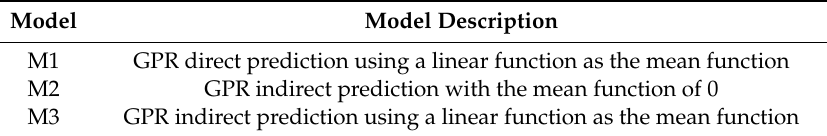
Table 2. Prediction models used in comparative experiments.